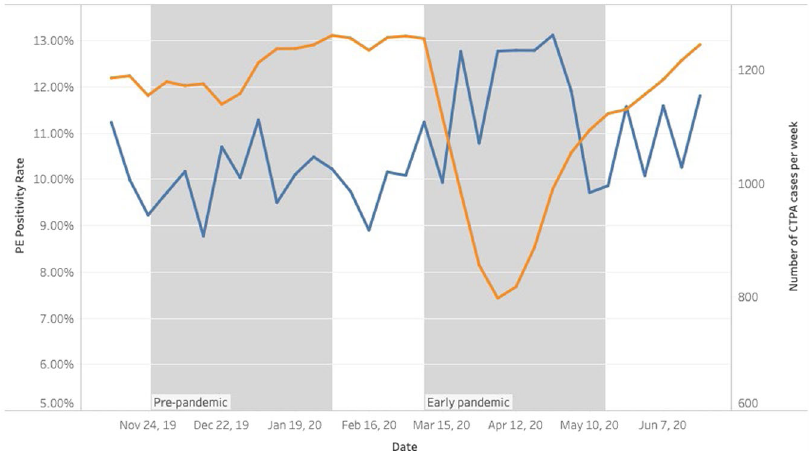
Fig. 3 Changes in CTPA utilization and PE positivity rate over time. Superimposed results demonstrate a drop in the centered 3-week moving average of weekly total CTPA exams performed (orange curve) with a simultaneous increase in PE positivity rates (blue